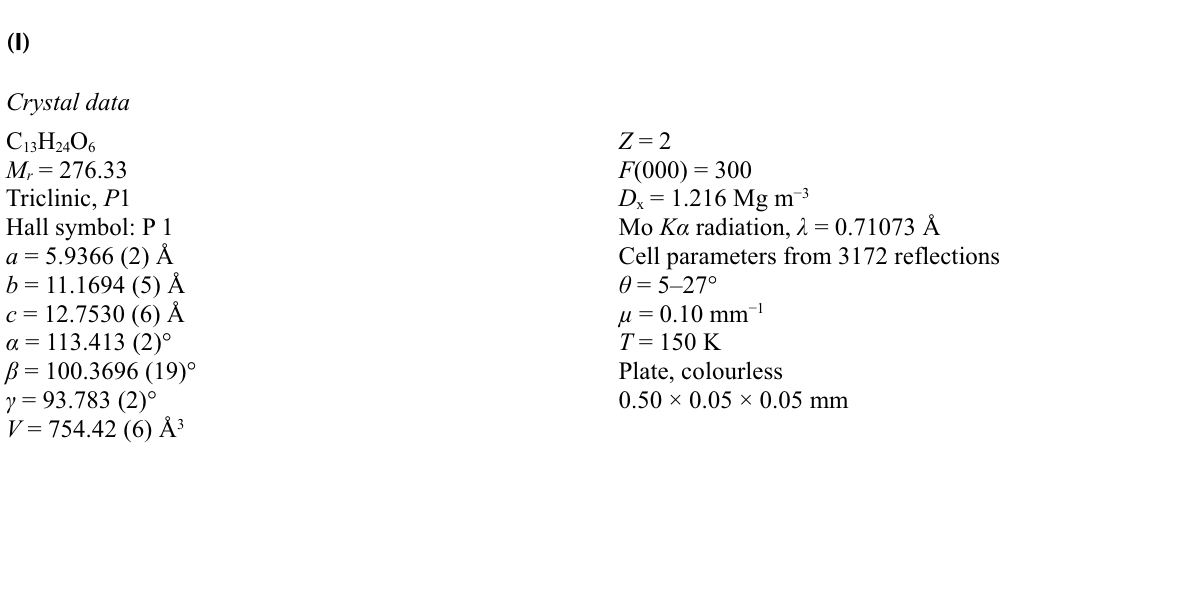
Packing diagram projected along the c -axis. The crystal structure consists of layers of hydrogen bonded molecules lying perpendicular to the c